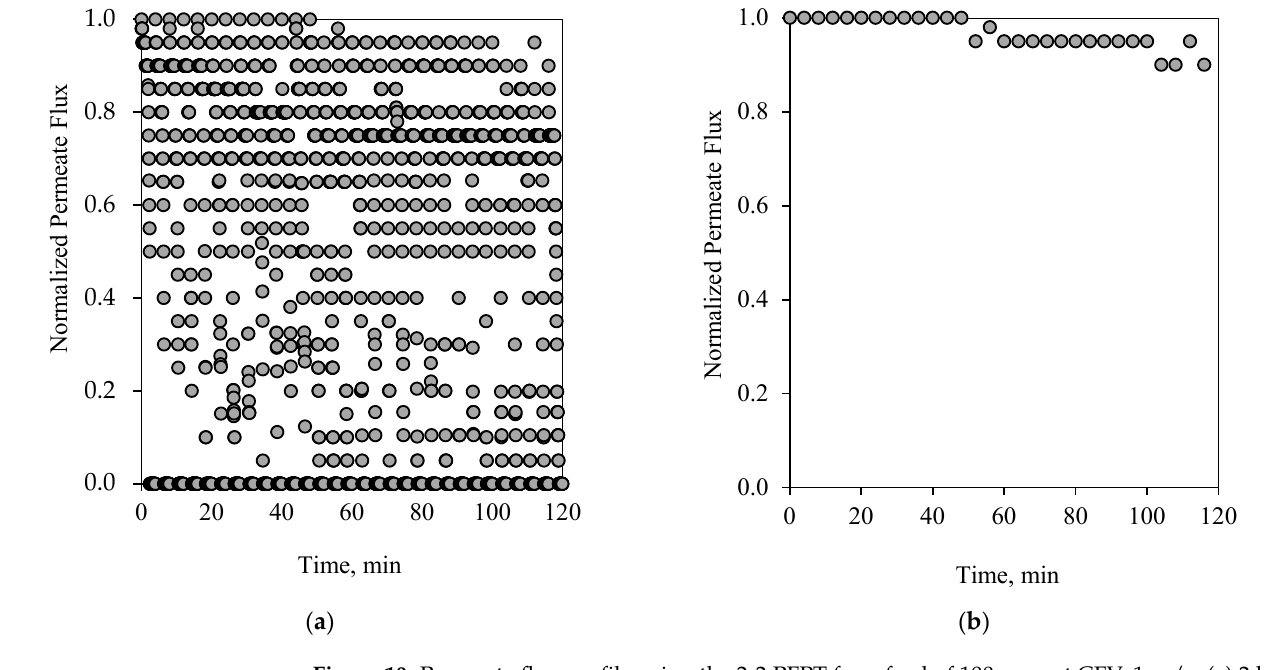
Figure 10. Permeate flux profile using the 2-2 PFPT for a feed of 100 ppm at CFV: 1 m/s: ( a ) 2 h of filtration operation, ( b ) membrane permeability after each cleaning half-cycle.